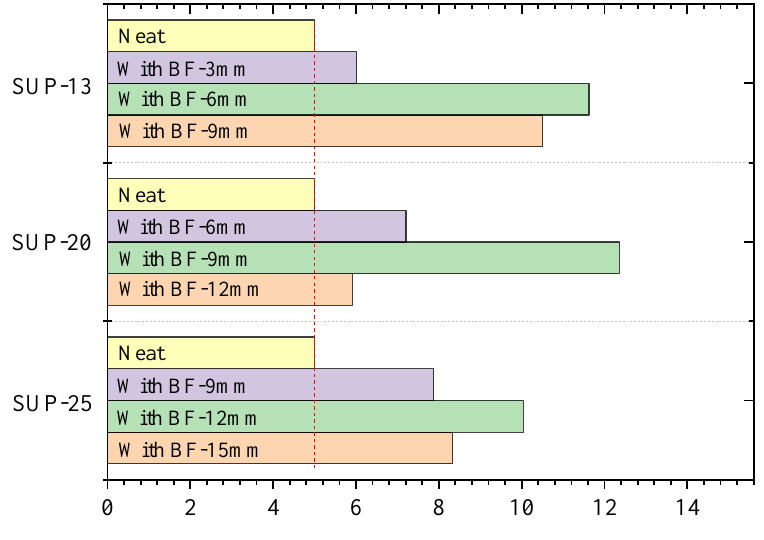
Figure 11. The sum of normalized results.